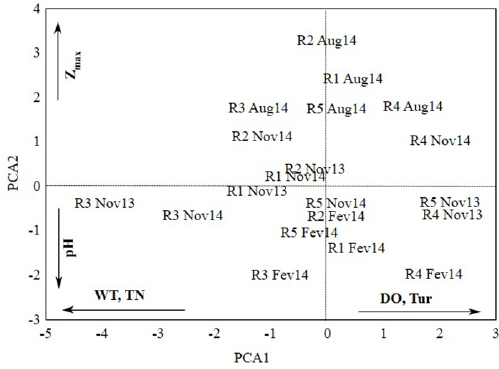
Figure 2. Dispersion of month-local scores along the first two axes of the PCA using the abiotic variables in the reservoirs (Ilha Solteira Reservoir - R1; Jupiá Reservoir - R2; Porto Primavera Reservoir R3; Três Irmãos Reservoir - R4; Rosana Reservoir - R5). DO: dissolved oxygen; Cond: electrical conductivity; WT: water temperature; Turb: Turbidity; Z : max